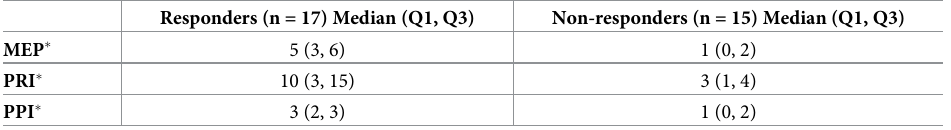
Table 3. DOMS intensity in responders and non-responders. Responders (n = 17) Median (Q1, Q3) Non-responders (n = 15) Median (Q1, Q3) MEP � 5 (3, 6) 1 (0, 2) PRI � 10 (3, 15) 3 (1, 4) PPI � 3 (2, 3) 1 (0, 2) MEP, movement evoked pain scale; PRI, Pain Rating Index; PPI, Present Pain Intensity Index